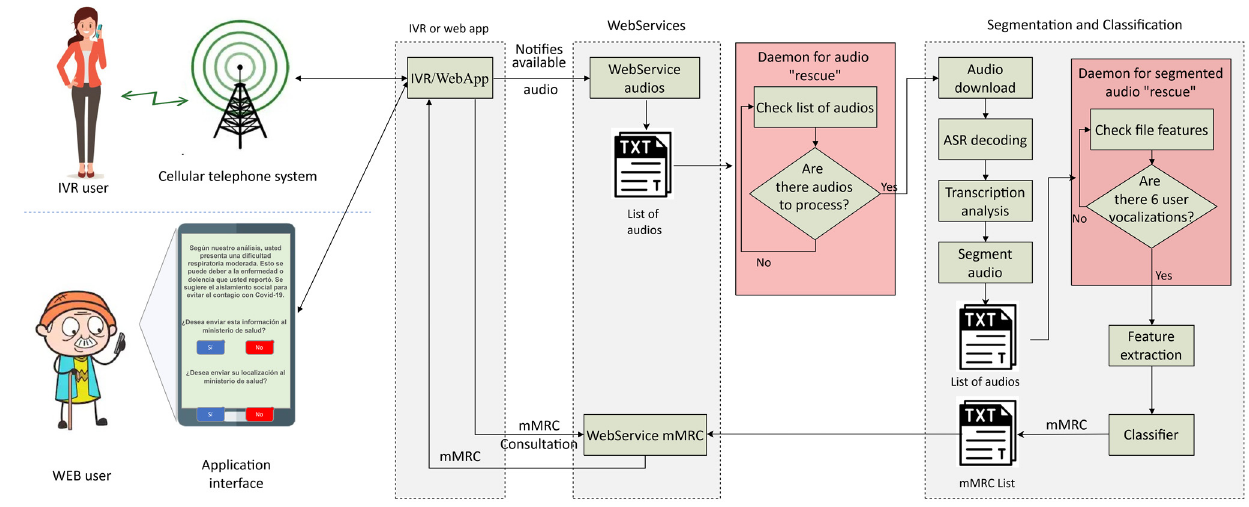
Figure 4. IVR and web ‐ based application